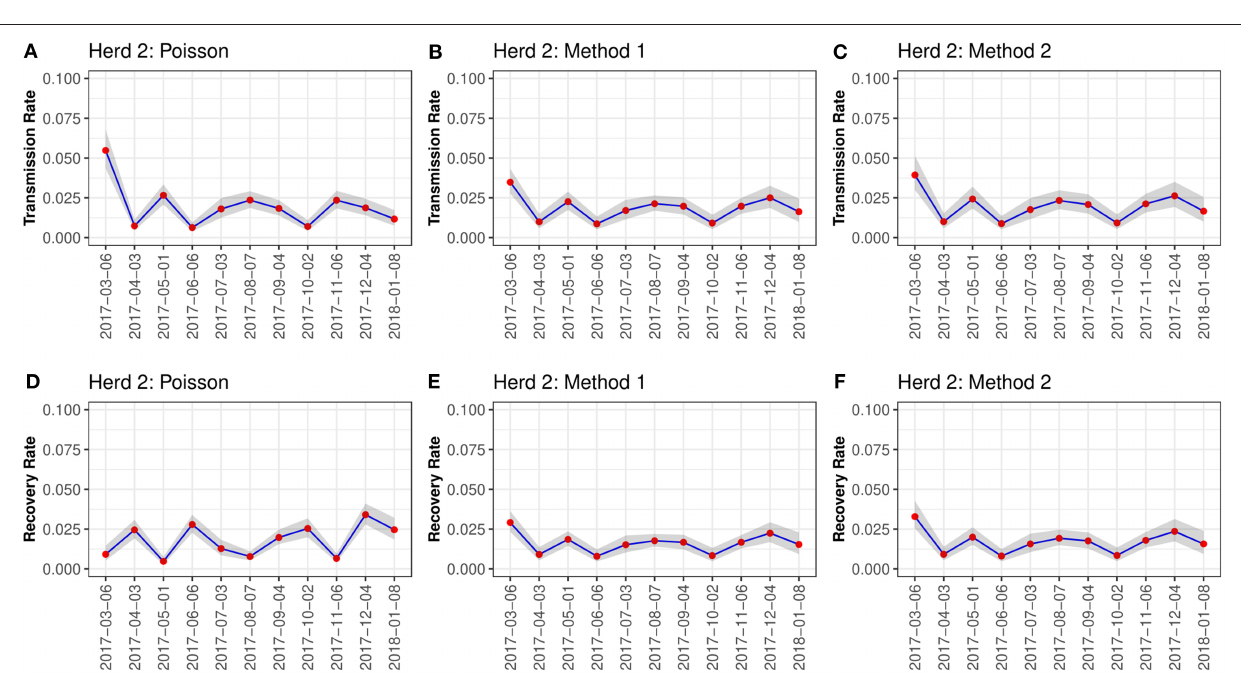
in herd 1 in spring and autumn, whereas this pattern was not clear in herd 2. The prevalence was higher in herd 1, whereas the variation in prevalence between sampling